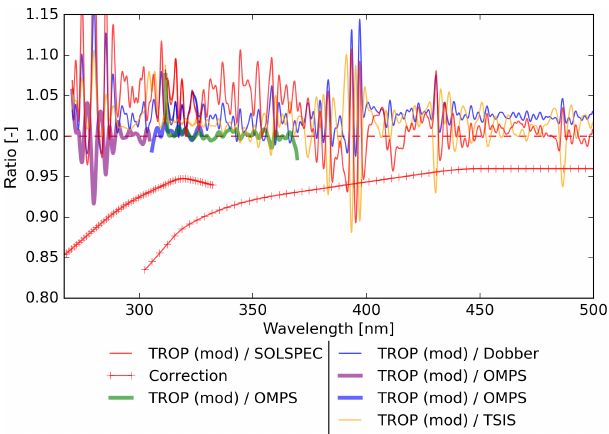
Figure 21. The ratio of the corrected spectrum via QVD1 in orbit 2818 with respect to the various reference spectra, convolved with a σ = 1 . 0nm Gaussian kernel. The thick purple, blue and green lines indicate the ratio with OMPS data which the correction is based on. The correction splines (red crosses) bring the TROPOMI spec- trum into good general agreement with several reference spectra. The spectrum shows similarity to the other spectra on a larger scale, except for a bias on the order of 0%–5%.